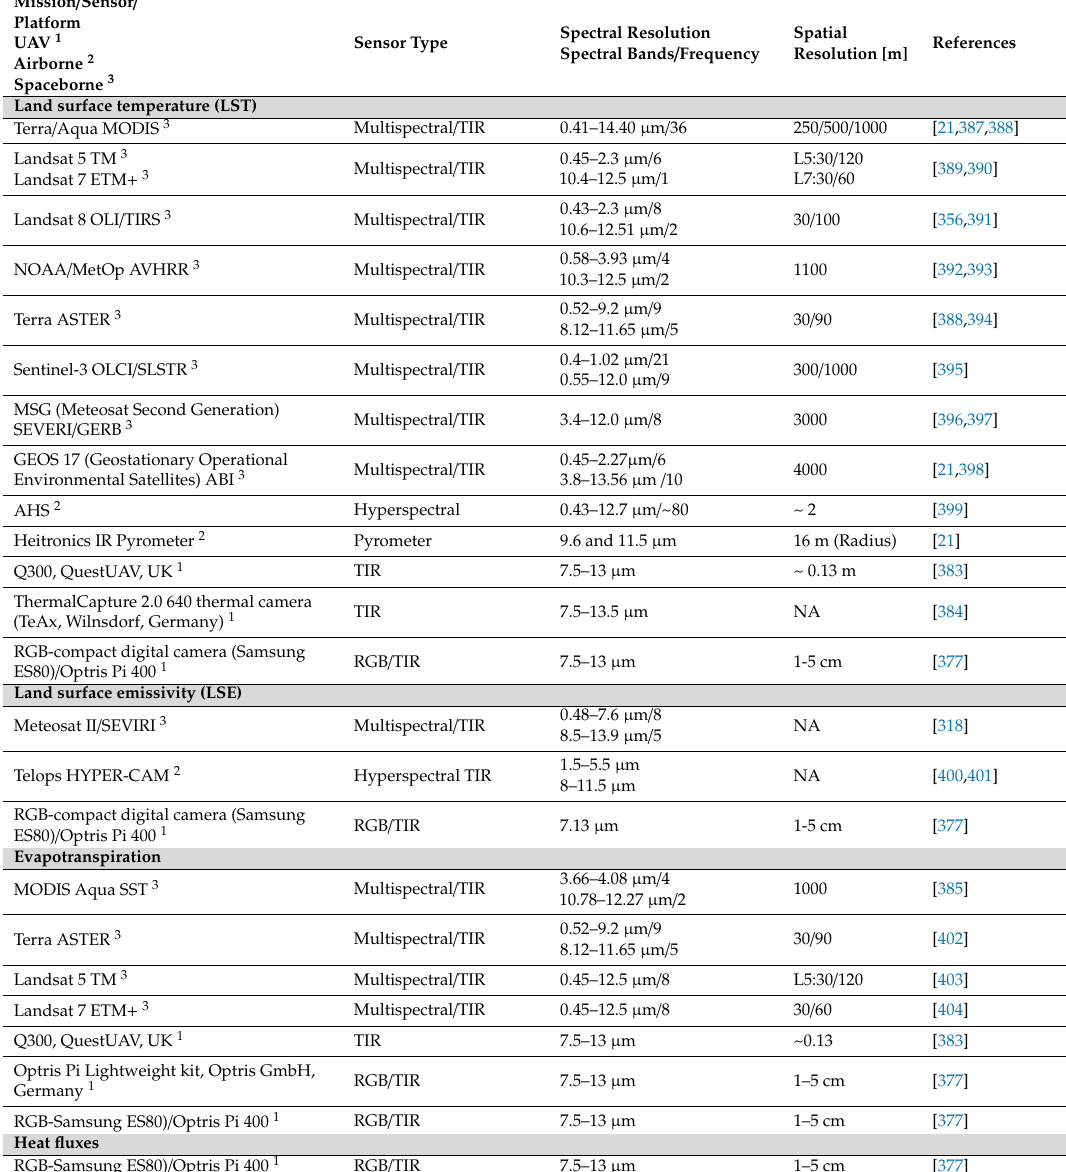
Table 7. RS-aided derivation traits of land surface temperature estimation and soil moisture characterization by thermal infrared (TIR) RS